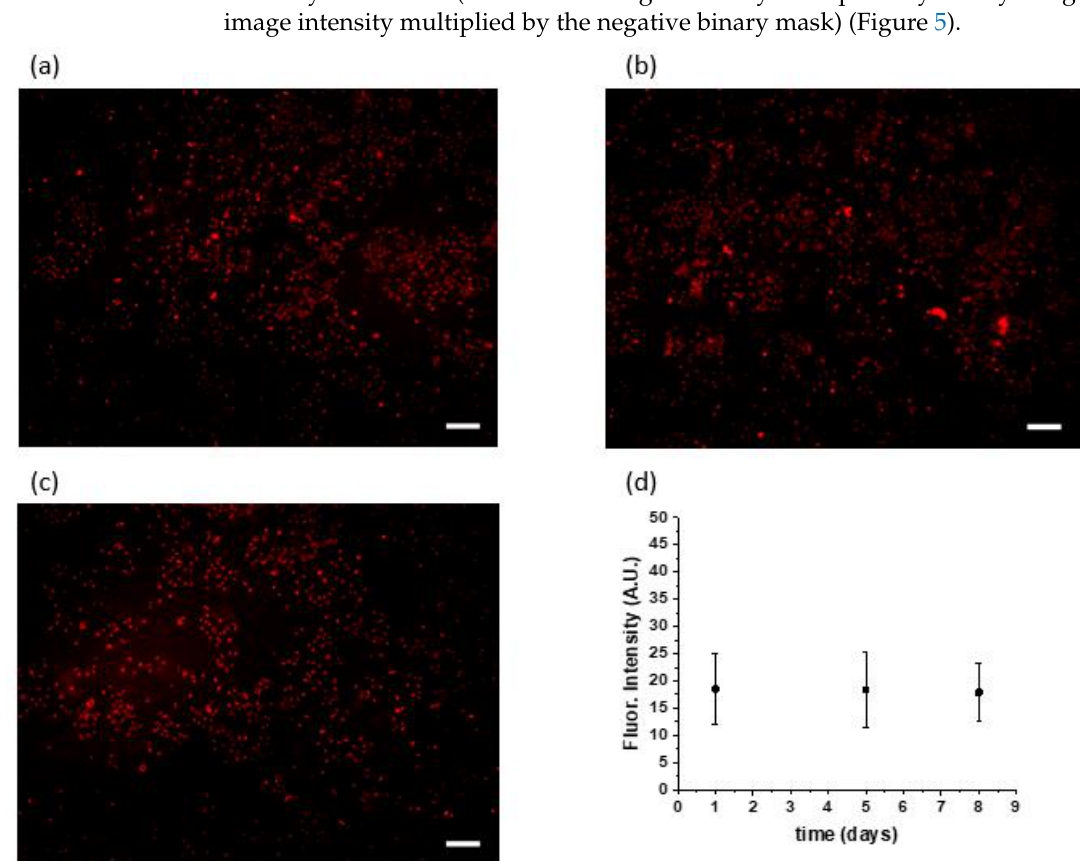
Figure 4. Monolayer cultures of A549 cancer cell line with GNPs inside at ( a ) day one, ( b ) day five, and ( c ) day eight. No significant difference was observed in GNP accumulation in cells over time, given that most GNPs are absorbed during the first 24 h; ( d ) n = 3. ( a – c ) Scale bar is equal to 200 µm. The longer retention time of GNPs in Matrigel relative to media. The transport of GNPs delivered in culture medium (which is overlaid on top of ECM) is presumably de-